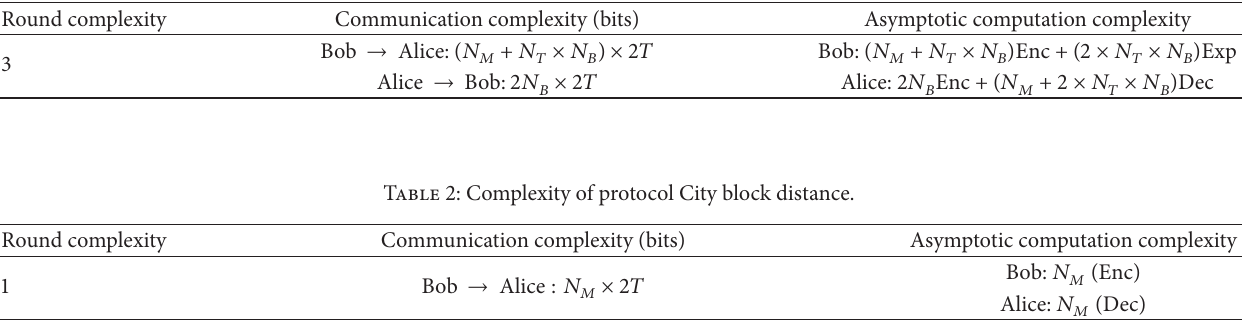
Table 1: Complexity of the protocol Euclidean-distance.